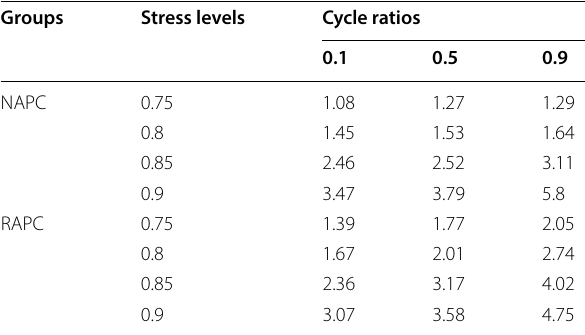
Table 5 Damping ratios at different stress levels (%). Groups Stress levels Cycle ratios